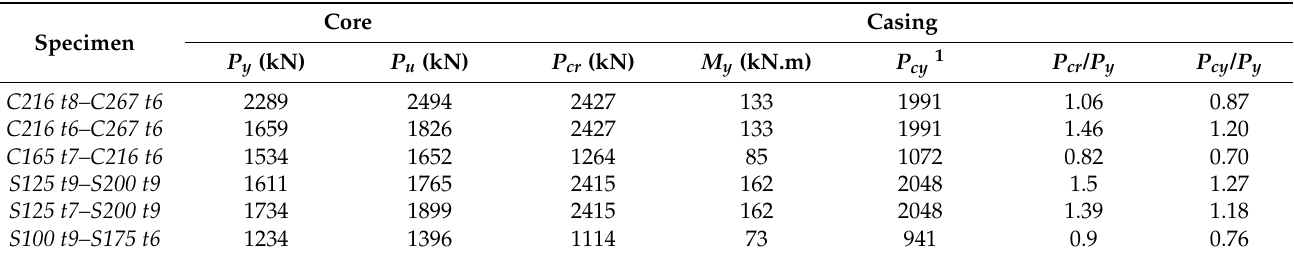
Table 3. Strength and stiffness